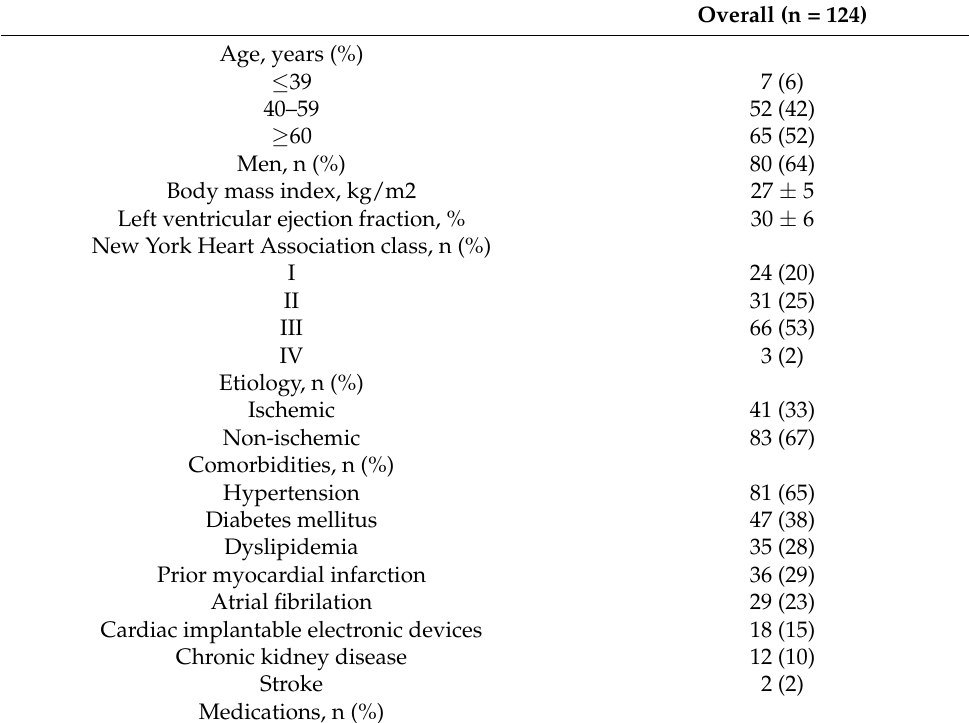
Table 1. Demographic and clinical characteristics of outpatients with